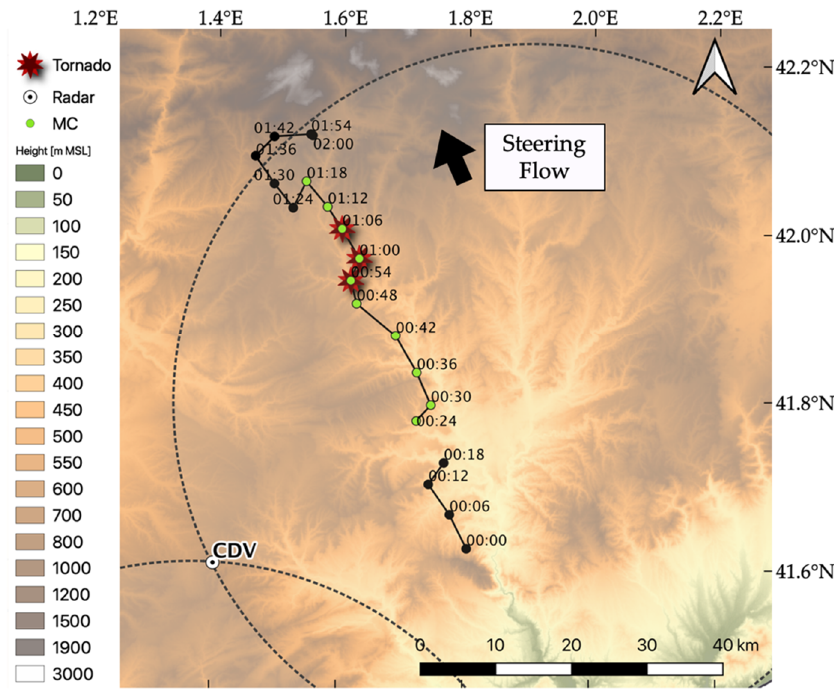
Figure 4. Track of the nocturnal winter tornado-producing storm on Central Catalonia on January 7 2018 over topography. Part of the 30 ◦ CDV-PBE pair dual lobes is depicted in the dotted lines. Dots indicate supercell centroid times labeled in UTC. Green dots indicate centroids where the mesocyclone was depicted in the Doppler velocity field as a radial velocity couplet. Red stars indicate confirmed tornado damage on the ground (post-event analysis). The black arrow indicates the steering flow at 3 km.